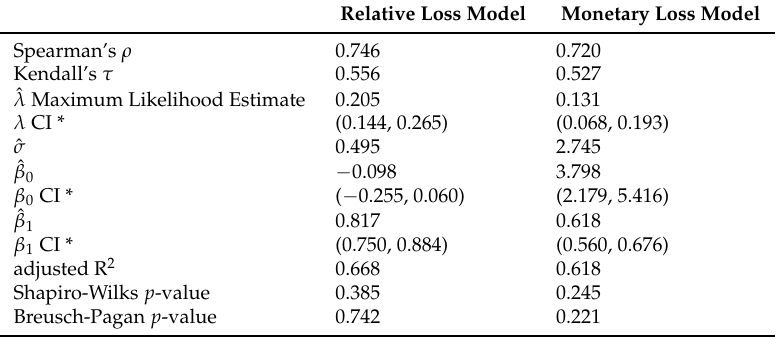
Table A1. Overview of the statistical evaluation and parameters of the two selected models. The estimates of β 0 , β 1 , λ and σ can be substituted in Equation (7) or (8) to predict the median or mean of y , respectively. * 95%-confidence